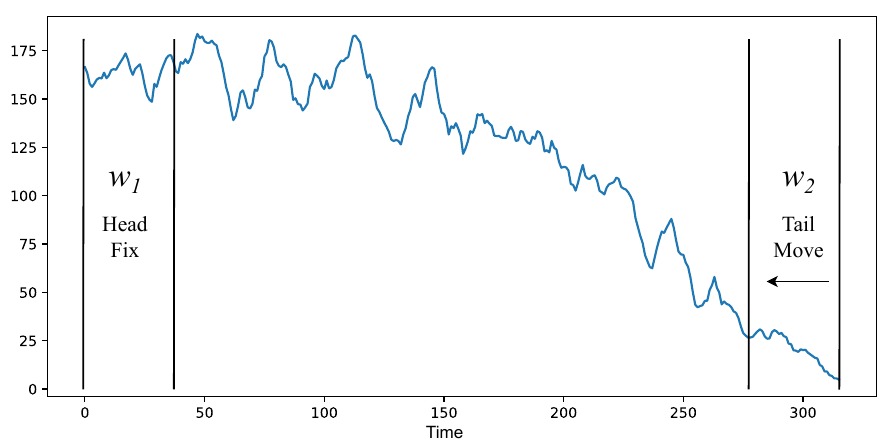
Figure 8. Explanation of HFTM strategy. We see one sliding window of observation from tail is moving while the sliding window from head is fixed.